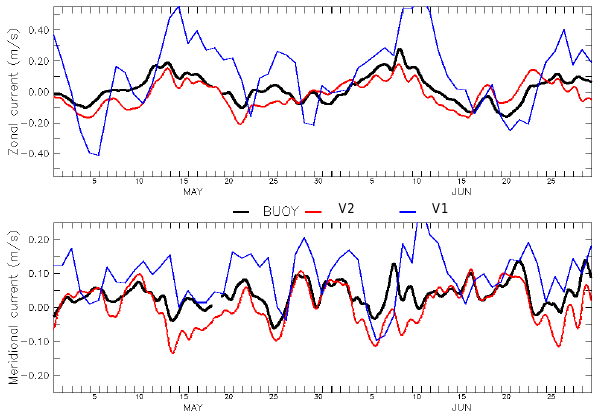
Figure 17 : Time series of zonal (top) and meridional (bottom) components of the current (m/s) at 3 meter depth for the period May-June 2009 at Estaca de Bares buoy (North-West Spanish coast near Capo Finisterra: see fig.7). Observation is in black, V2 system in red and V1 system in blue. Residual current on May-June 2009 at the mooring Estaca de Bares (North-West Spanish coast near Capo Finisterra: see fig.7).